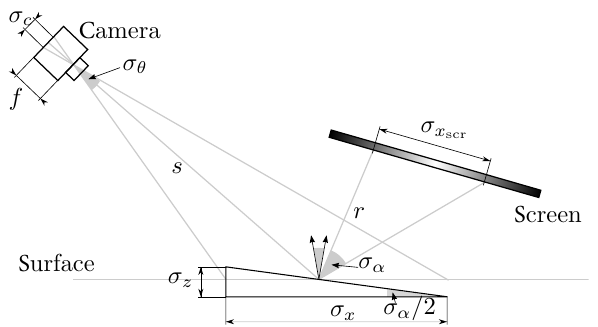
Figure 7. Measurement uncertainty σ z of a deflectometric system with lateral uncertainty σ x caused by discretization σ c on the cam- era sensor and uncertainty of the origin of incident rays from the screen σ x caused by the phase-shifting scr